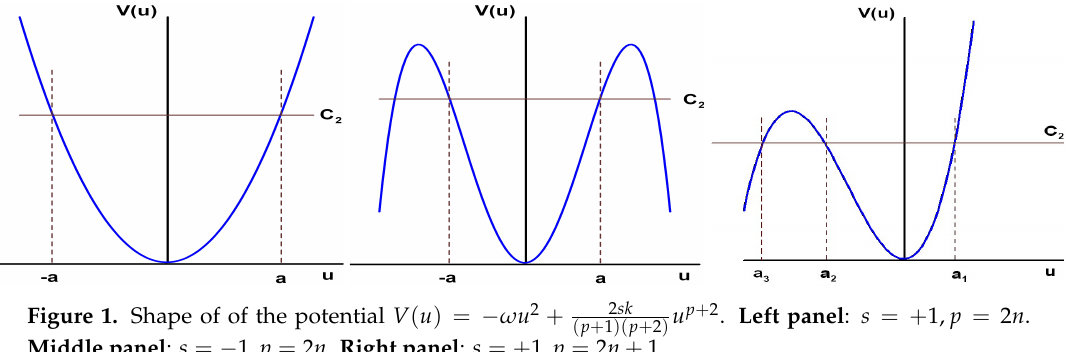
u p + 2 . Left panel : s = + 1, p = 2 n . ( p + 1 )( p + 2 )